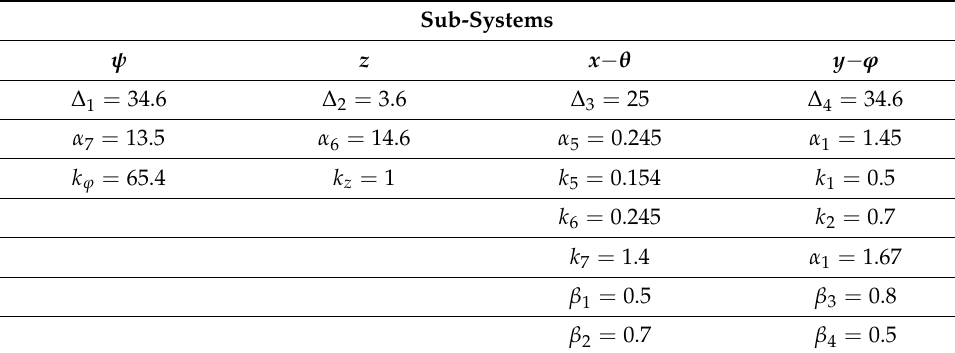
Table 3. Values of Gains for the Prescribed Sub-systems.